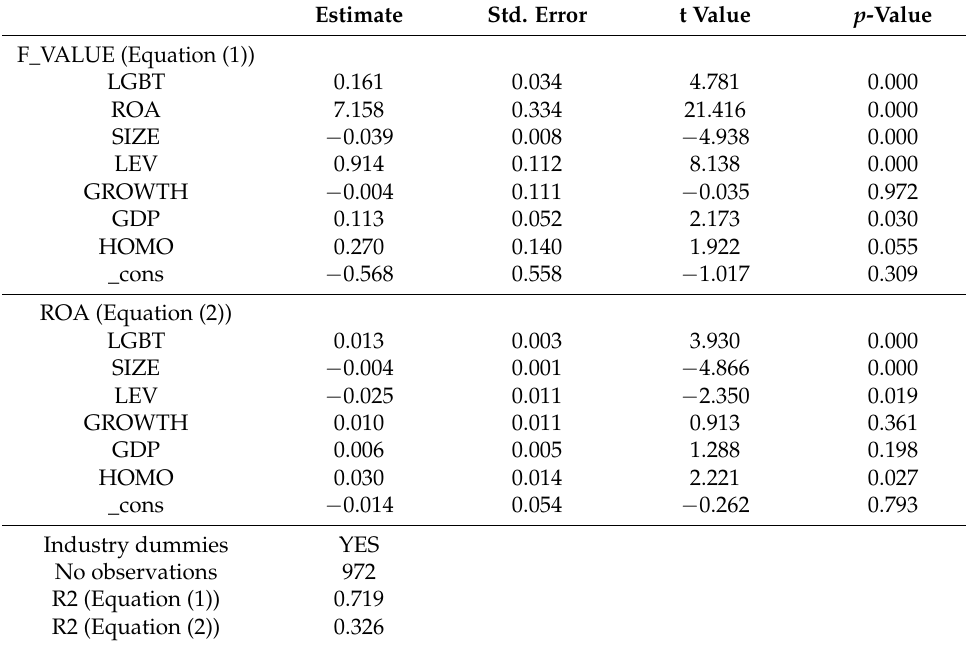
Table 5. Results of the simultaneous